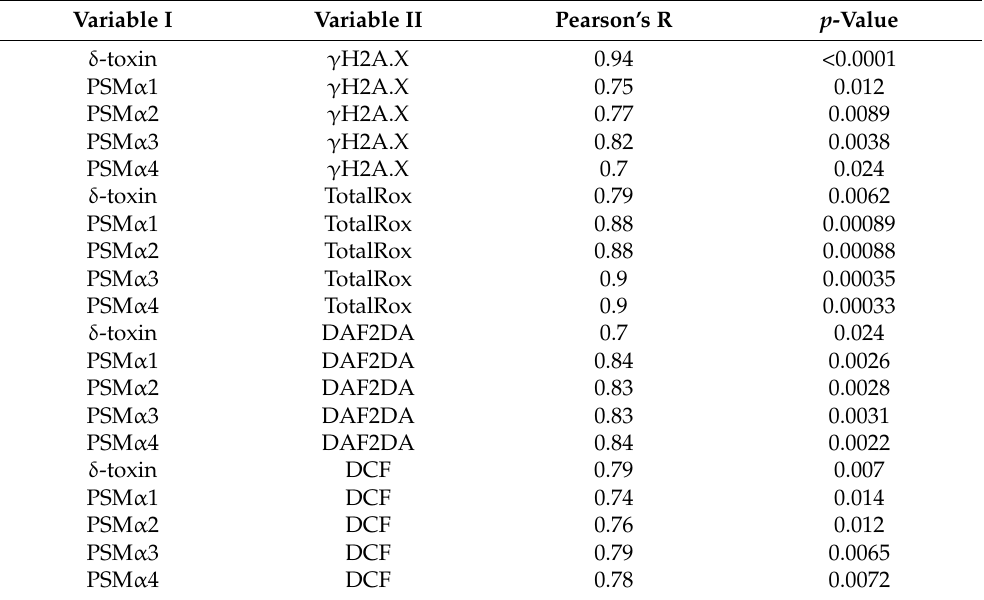
Table 1. Secreted phenol soluble modulin (PSM) levels correlate positively with the oxidative and genotoxic ability of S. aureus secretomes on human keratinocytes. Targeted mass spectrometry was used to measure phenol soluble modulins α 1-4 and d-toxin in secretomes from Staphylococcus assayed in Figure 5A. Pearson’s correlation analysis was conducted to examine the correlation between relative PSM level and ROS or DNA